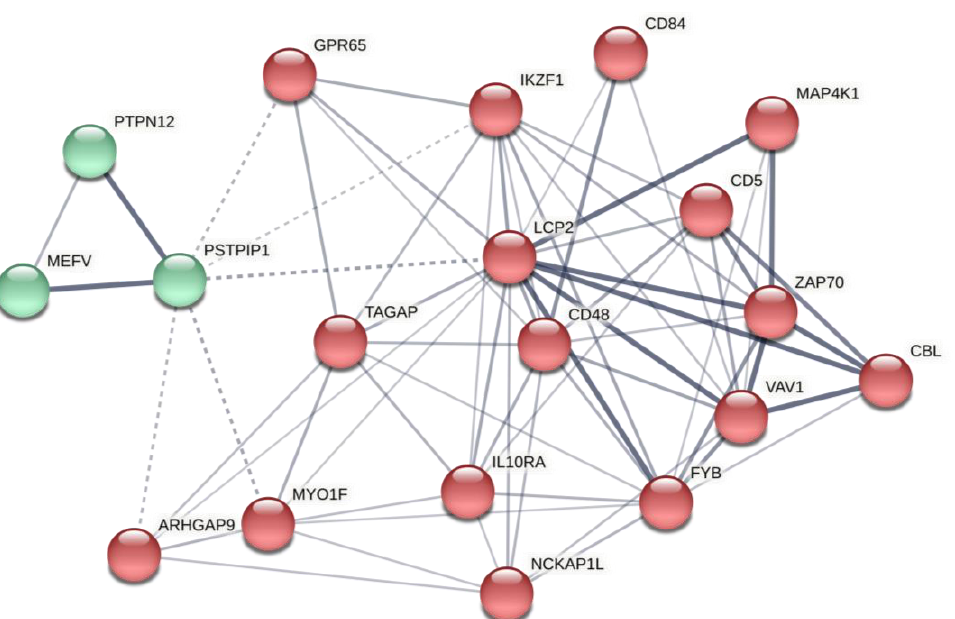
Figure 5. Network 2: Interaction network based on initial predicted co-expression regulatory network. This network was reconstructed by 14 genes involved in the predicted co-expression regulatory network as inputs. Each cluster is illustrated with a different color. Edges represent protein–protein associations. Chromatic edges indicate highest (0.9), high (0.7), medium (0.4), and low (0.15) confidence. Inter-cluster edges are shown with dashed lines.